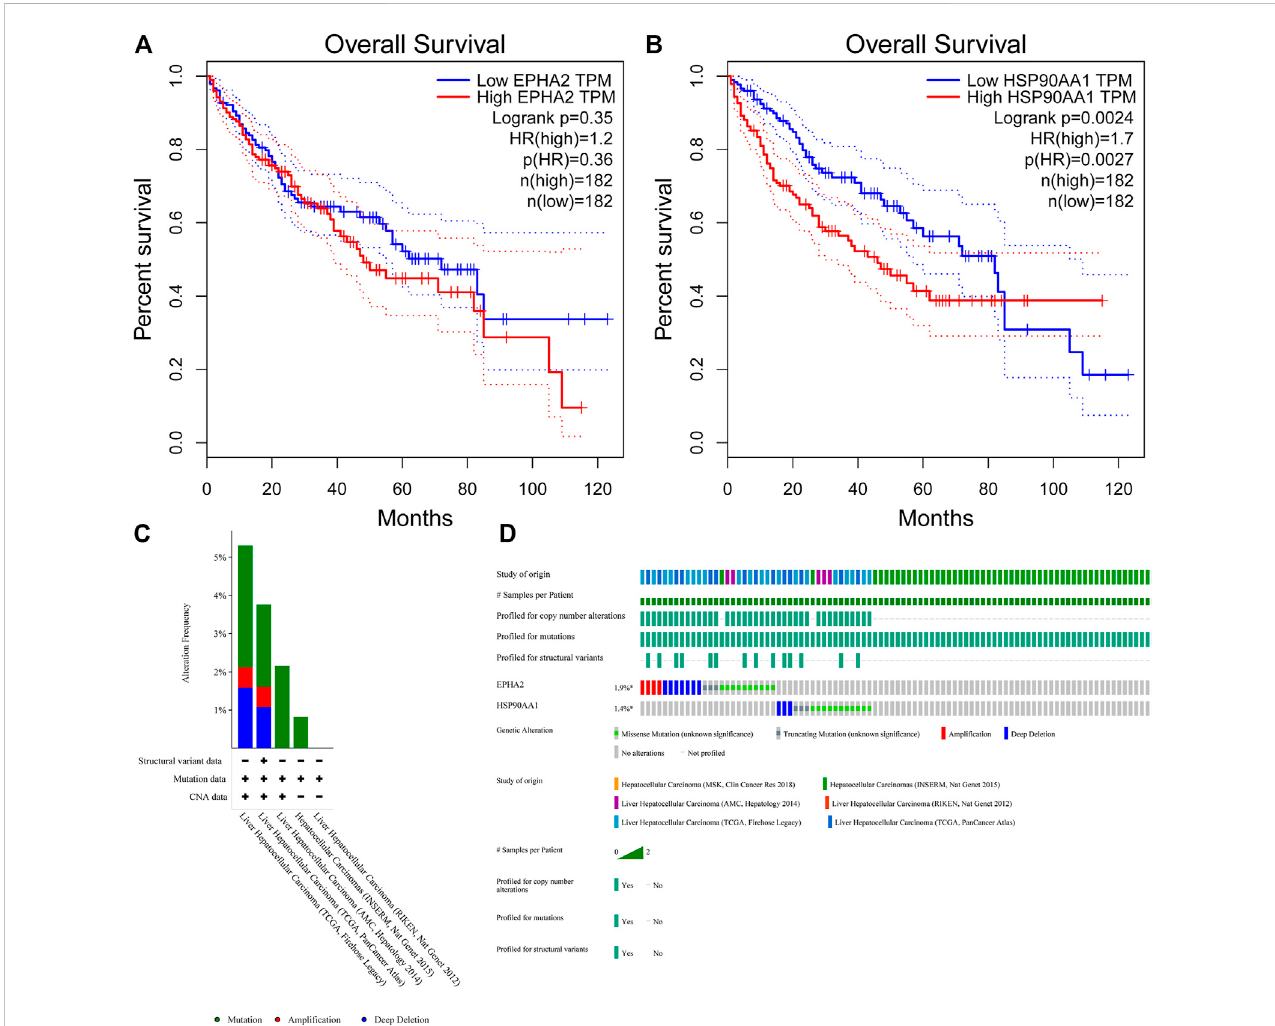
FIGURE 7 (A, B) Survival analysis of high and low expression populations of EPHA2 and HSP90AA1. (In the fi gure, the red curve refers to the population with high expression in the TCGA database, and the blue curve refers to the population with low expressionin theTCGA database. The P value represents the statistical difference in the survival curve between the two groups). (C, D) Genetic mutation analysis of EPHA2 and HSP90AA1 in various TCGA datasets. (C) The percentage of total mutations of EPHA2 and HSP90AA1. (D) The mutations of EPHA2 and HSP90AA1 in each